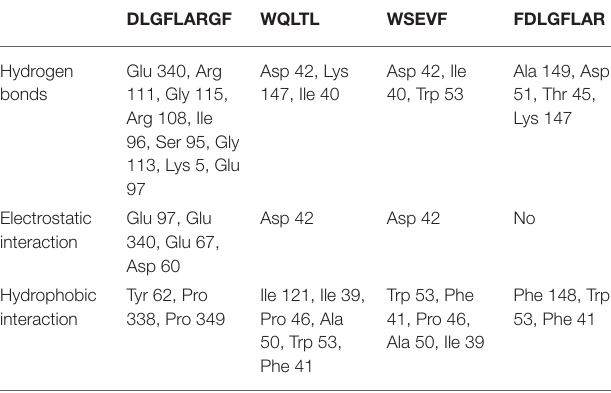
TABLE 4 | Docking results according to hydrophobic interaction, electrostatic interaction and hydrogen bond for